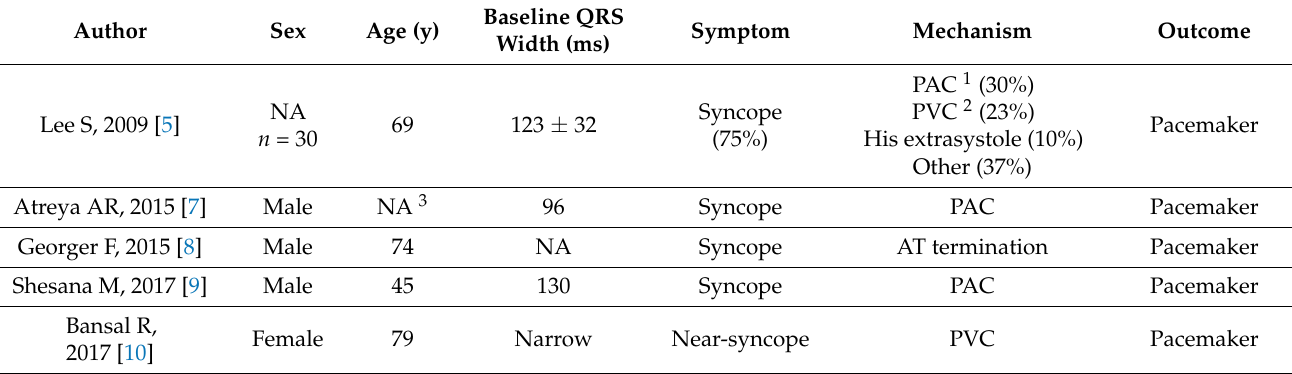
Figure 4. Example of two other mechanisms of pause-dependent atrioventricular blocks. The telem- etry strips show a counterclockwise isthmus-dependent flutter termination followed by PD-AVB (upper panel). In the same patient (11 from Table 2), another episode could be recorded, induced by a premature ventricular contraction. Surface ECG showed a PD-AVB episode induced by a His ex- trasystole (arrow) as shown by the retrograde P wave visible (lower panel). A blocked premature atrial contraction may not be ruled out (patient 13 in Table 2).